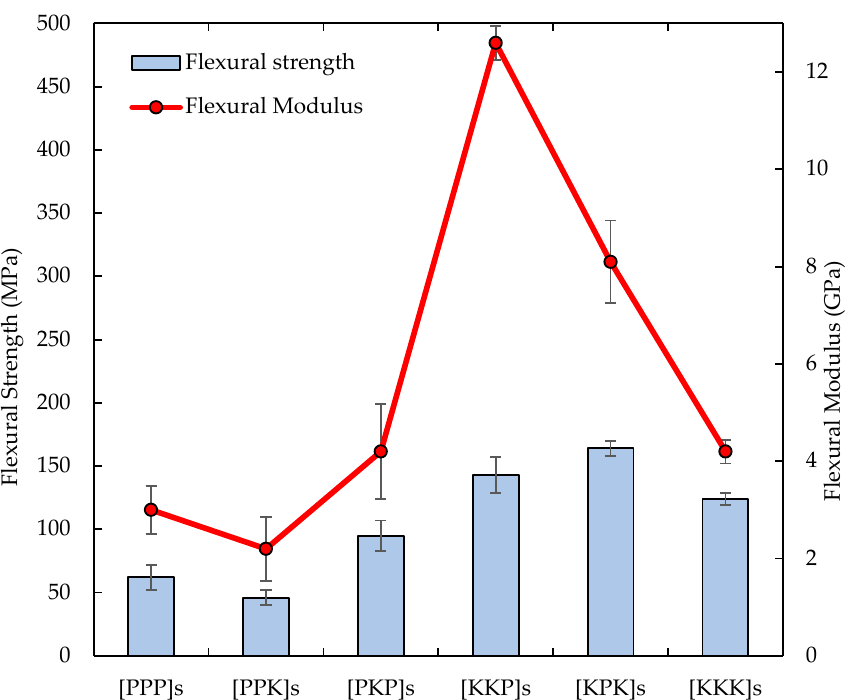
Figure 8. The flexural strength and flexural modulus of PALF/Kevlar-reinforced UP hybrid composite laminates with different stacking sequences.